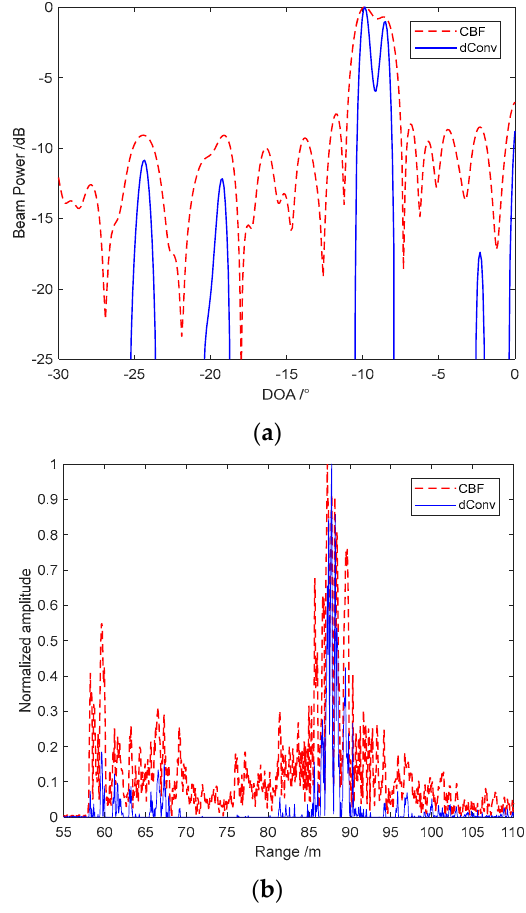
Figure 10. Sliced comparison between CBF and accelerated deconvolved beamforming: ( a ) beamwidth comparison between CBF and accelerated deconvolved beamforming; and ( b ) echo energy comparison between CBF and accelerated deconvolved beamforming.